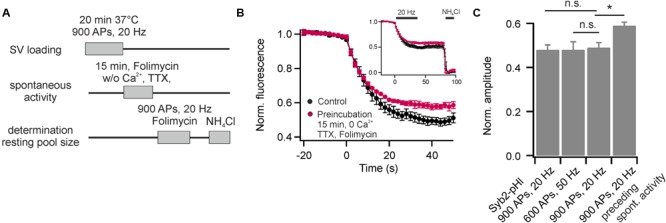
The recycling pool of SVs is the source of spontaneous release. (A) Experimental paradigm to probe the origin of spontaneously recycling SVs. (B) Recycling pool size probed with 900 APs at 20 Hz in presence of Folimycin for control (black) and after pre-incubation of neurons for 15 min at 37°C in presence of TTX, zero external calcium and Folimycin (red). The inset shows complete traces including NH4Cl-superfusion (n = 5 coverslips, 150 to 350 boutons each). (C) Quantification of the recycling pool size for Syb2-pHl (shown in Figure 5A) and for DOPE-cypher5E [shown in Figure 5B and (B)]. The reduction in apparent recycling pool size after a period of spontaneous activity in presence of Folimycin indicates a cross-depletion of the recycling pool by preceding spontaneous activity. Thus, most spontaneously recycled SVs were drawn from the recycling pool. (∗p < 0.02; n.s., not significant, p > 0.4, unpaired t-test). All error bars represent SEM.